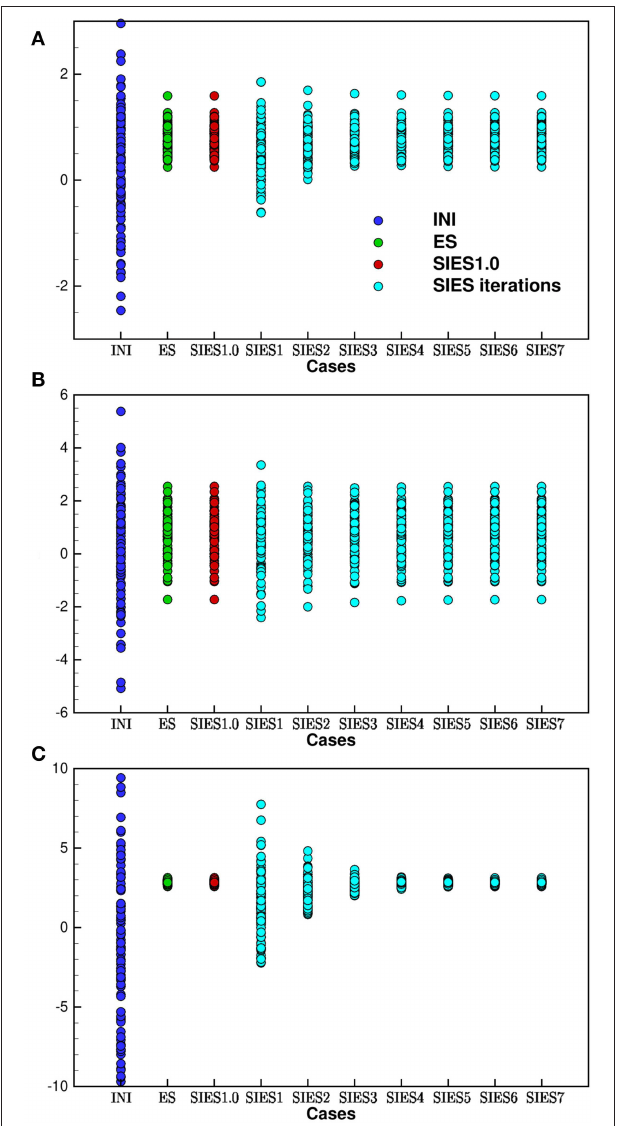
FIGURE 3 | Coefficients a , b , and c for the polynomial Gauss-linear case: The solution using ES and SIES in the Gauss-linear case should all be identical realization per realization. The dark blue circles are the realizations of the initial ensemble. The green circles are the original ES in ERT, which are identical to the SIES scheme with a single iteration of step-length equal to 1.0 (denoted SIES1.0) shown as the red circles. The cyan circles denote iteration steps using SIES with a step length of 0.5, which also converges exactly to the ES solution.